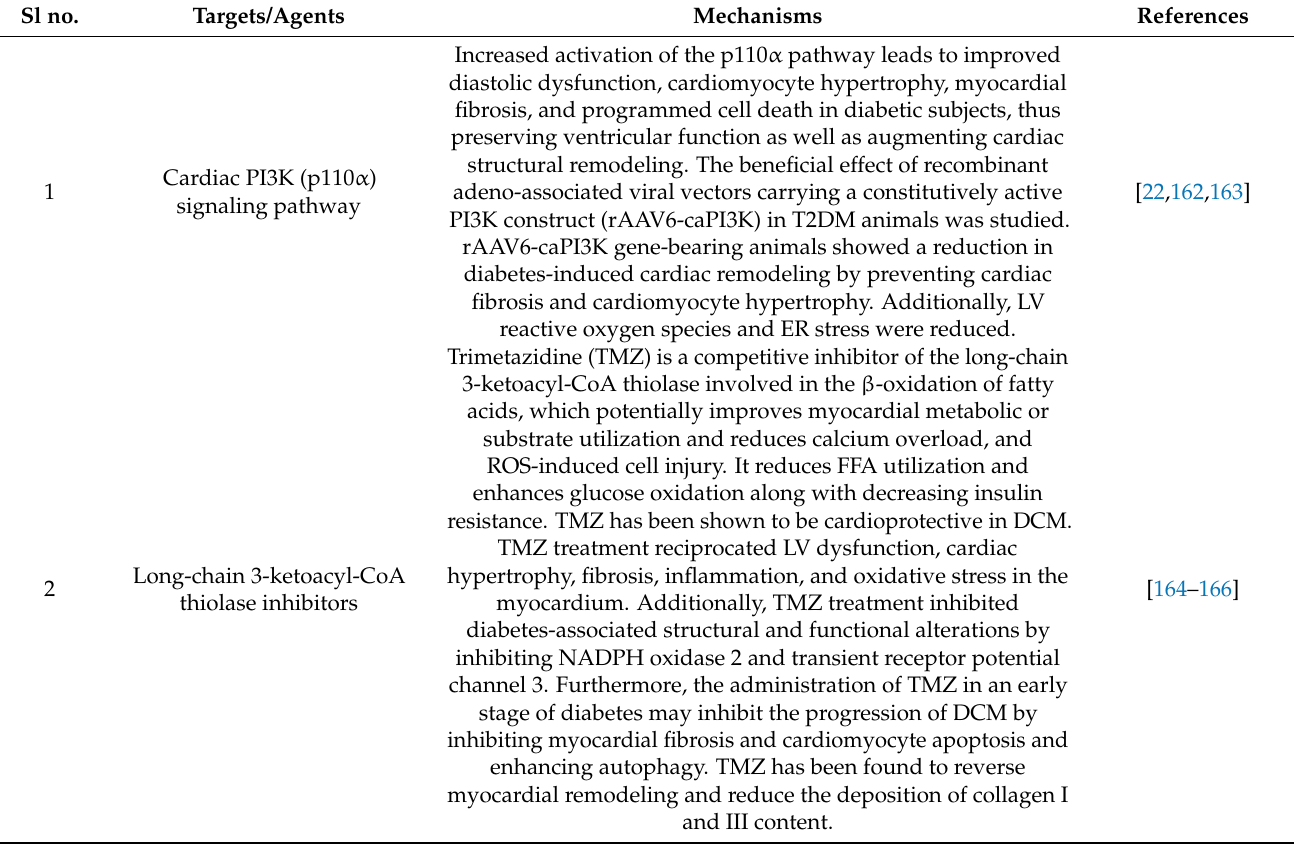
Table 2. Modulation of signaling pathways as promising targets. Sl